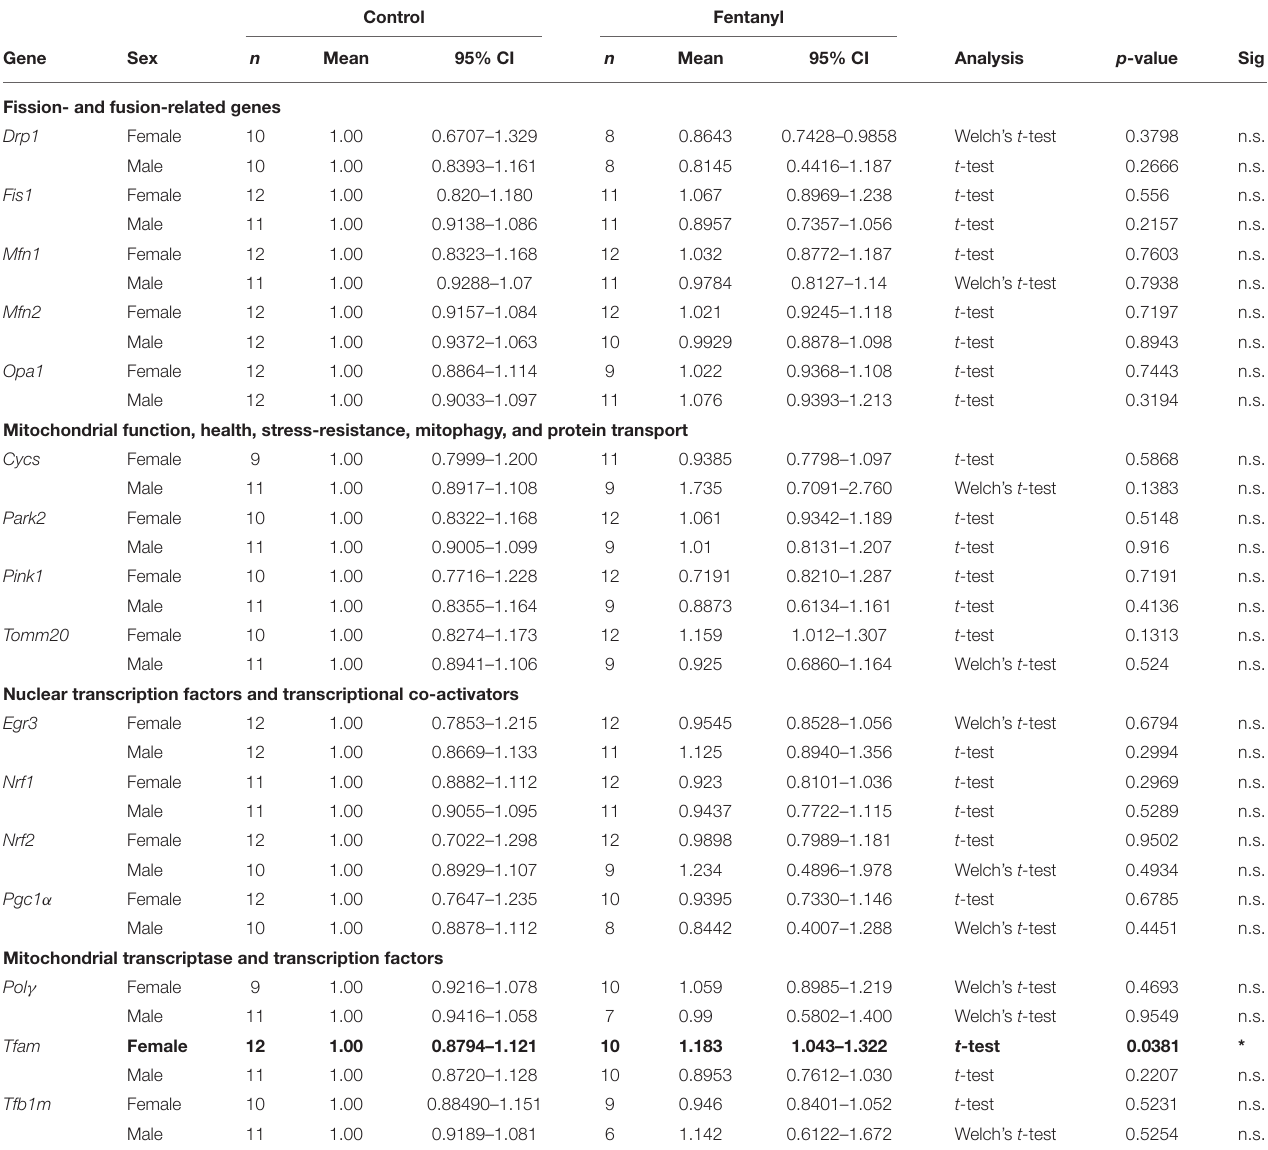
TABLE 1 | Relative gene expression of nuclear mitochondrial related genes in